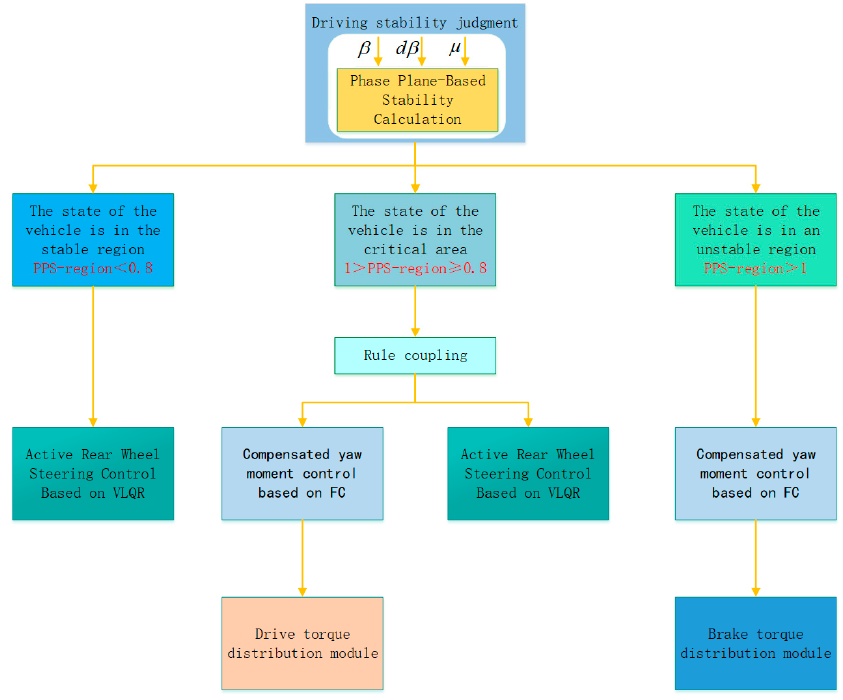
Figure 14. Coordinate the execution process of the control strategy.